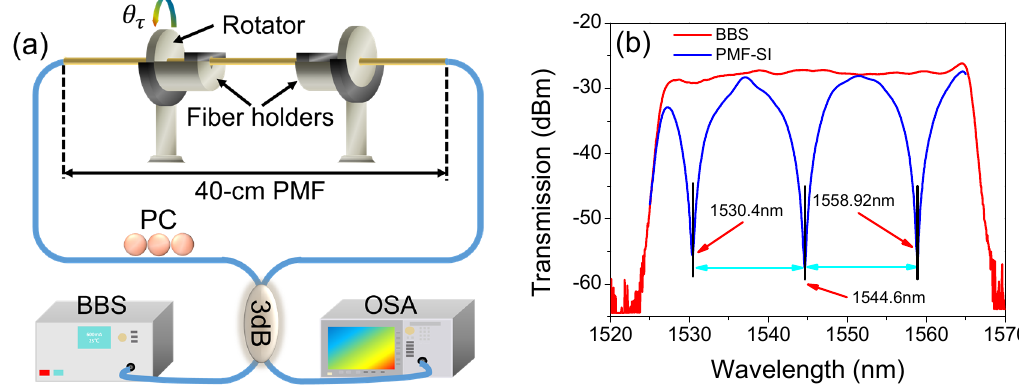
Sensors 2019 , 19 , x FOR PEER REVIEW Figure 2. ( a ) The experimental setup for passive torsion-sensing and ( b ) the transmission spectra of BBS and PMF-SI. PMF: polarization-maintaining fiber, PC: polarization controller BBS: broadband source, OSA: optical spectrum analyzer, SI: Sagnac interferometer.